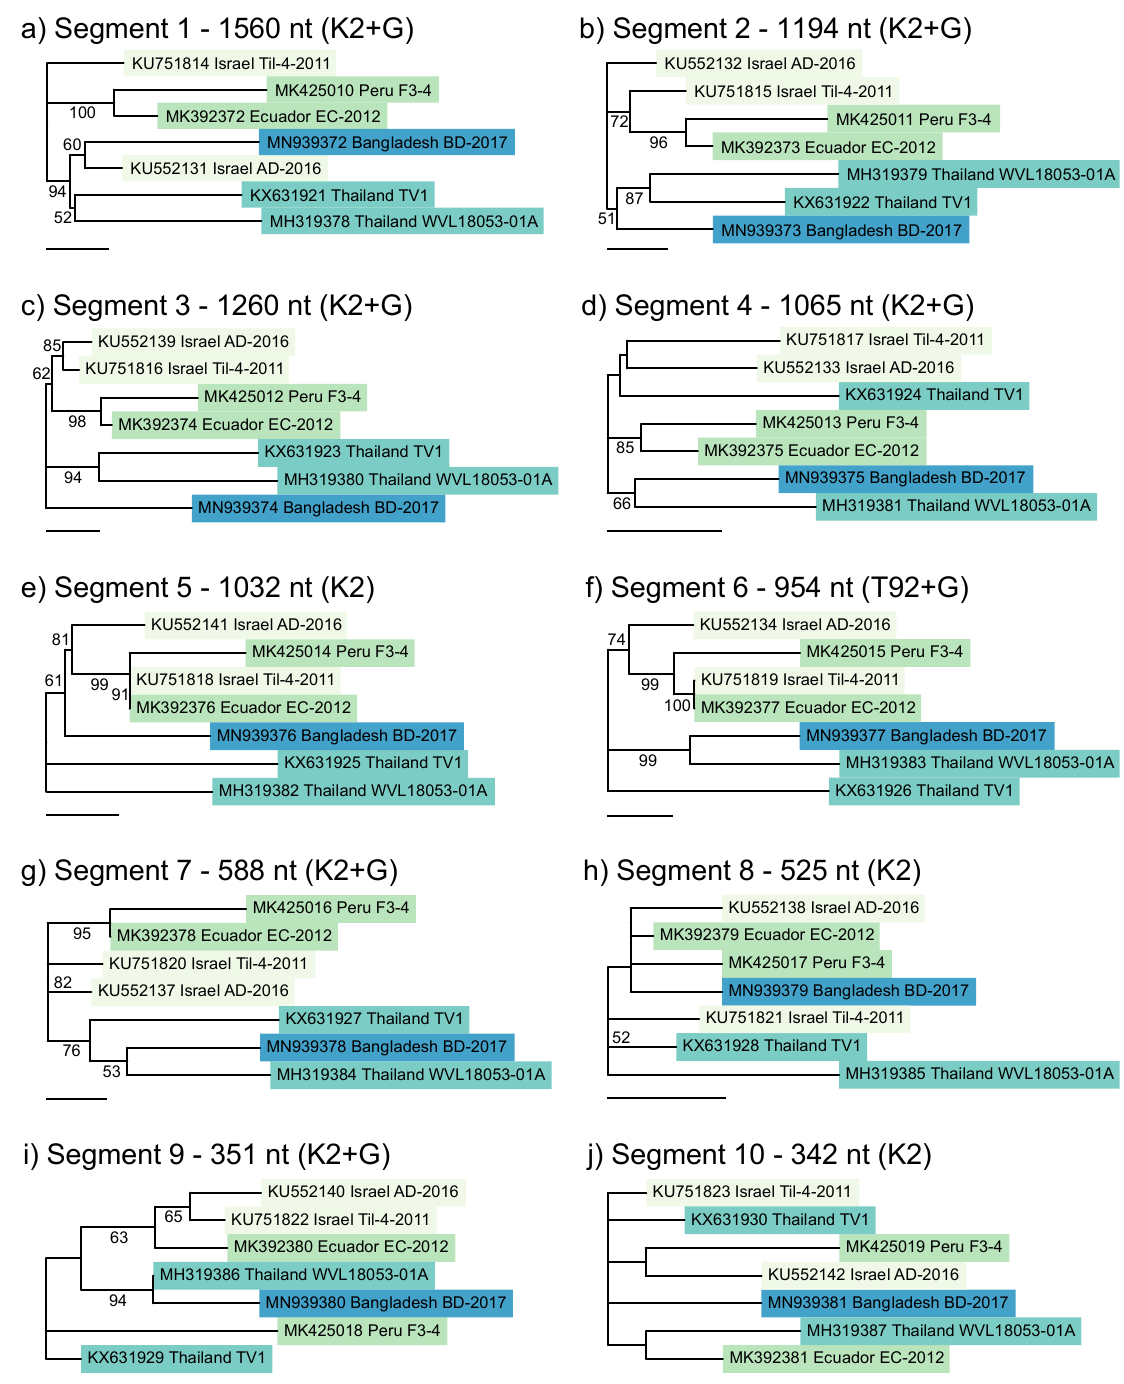
Figure 4. Maximum likelihood phylogenetic trees of the ten TiLV segments, using only isolates for which the full coding regions of all ten segments have been sequenced. ( a ) Segment 1; ( b ) Segment 2; ( c ) Segment 3; ( d ) Segment 4; ( e ) Segment 5; ( f ) Segment 6; ( g ) Segment 7; ( h ) Segment 8; ( i ) Segment 9; ( j ) Segment 10. Alignment lengths and best-fitting nucleotide substitution models are shown in panel headings (K2 = Kimura 2 parameter model, T92 = Tamura 1992 model, + G = gamma-distributed rate heterogeneity). Bootstrap values were calculated from 1000 replicates, and percent support is shown on nodes where values exceed 50%. Scale bars show 0.01 substitutions per site. Colours show isolates from the same